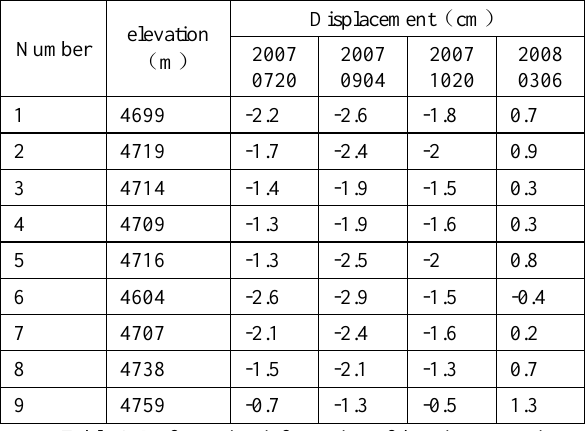
Table 2. Deformation information of the nine test points